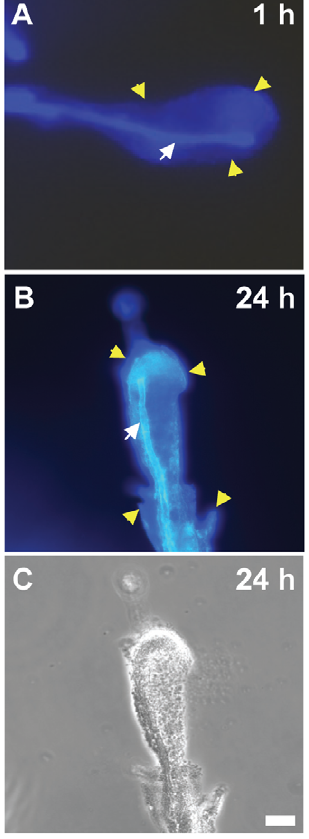
Figure 4. Detection of cellulose in biofilms on A.niger . Micrographs of S . Typhimurium biofilms on the fungal hyphae after 1 h (A) and 24 h (B and C) of co-incubation. Top and middle panel images show the fluorescence emitted from the chitin in the fungal cell wall (white arrows) and from the bacterial cellulose present in the biofilms (yellow arrows) after staining with Calcofluor White and UV illumination. Figure C is a phase contrast version of the epifluorescence image shown in B. Scale bar, 20 m m.